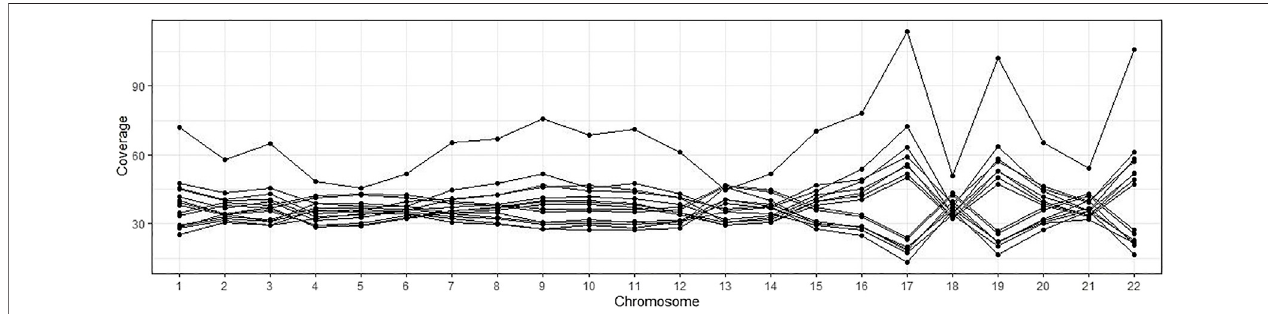
FIGURE 2 | Alignment coverages of 15 samples with uneven sequence data. Each line is a sample, and each dot presents the alignment coverage for a chromosome.